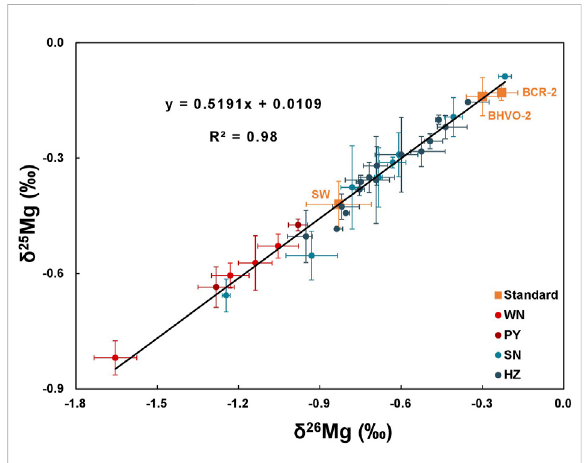
FIGURE 2 Diagram of δ 26 Mg vs δ 25 Mg values for human dental enamel. The solid line represents the fractionation line with a slope of 0.519. Error bars indicate the 2SD of the mean